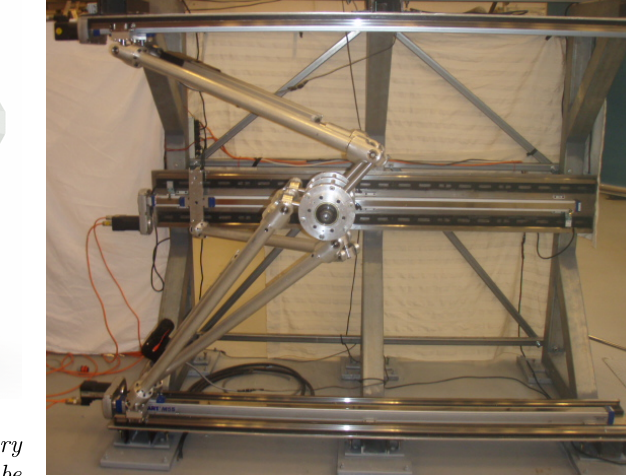
Figure 16: Another implementation of the Gantry Tau with 5 DOF parallel control of the manipu- lated platform. In this version the links are also arranged in such a way that it is possi- ble to reconfigure the robot to work in both right and left